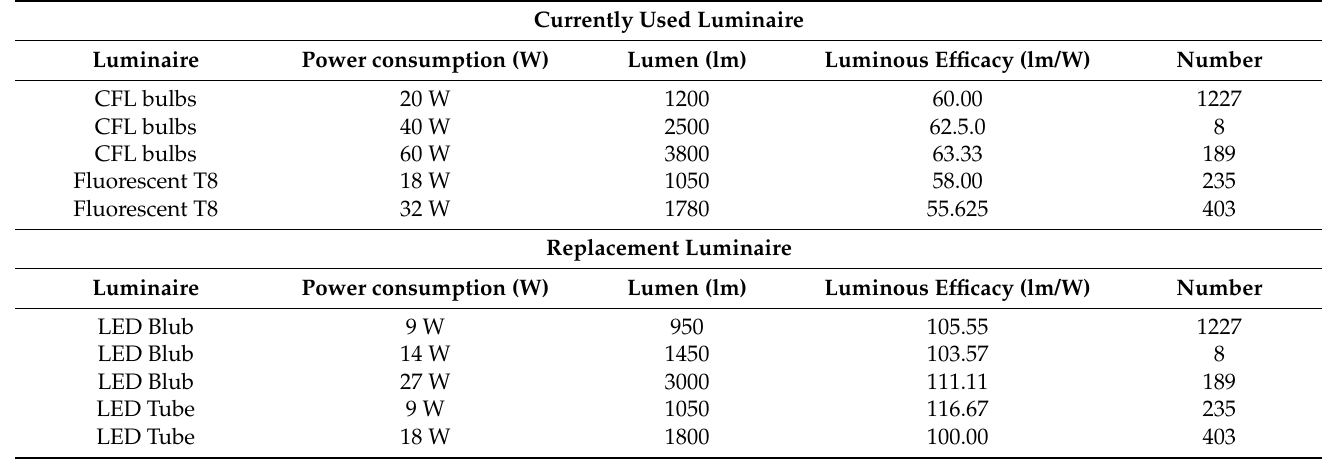
Table 10. Specifications of luminaires employed in the lighting systems of the case-study building. CFL: compact fluorescent.